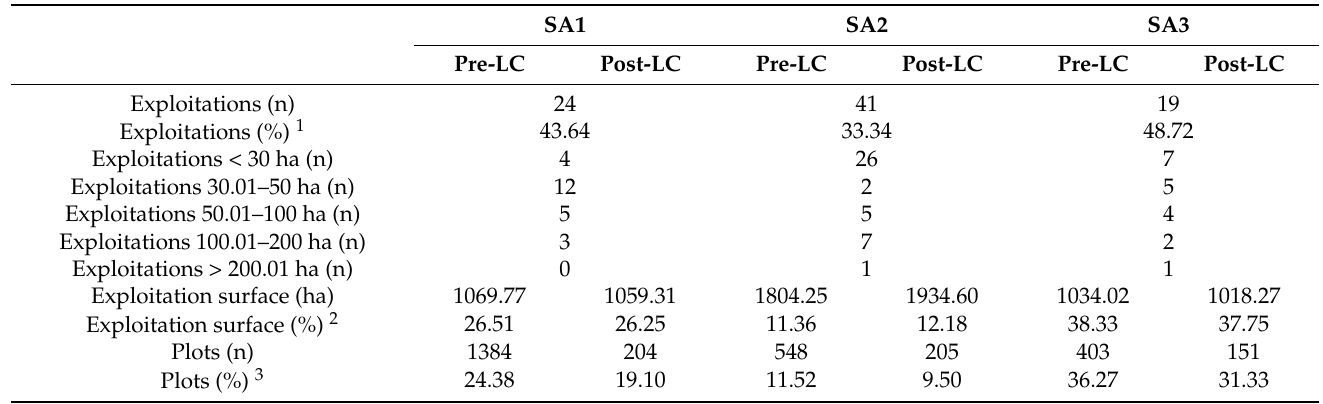
Table 2. Structure of the sample considered in each area (Pre and